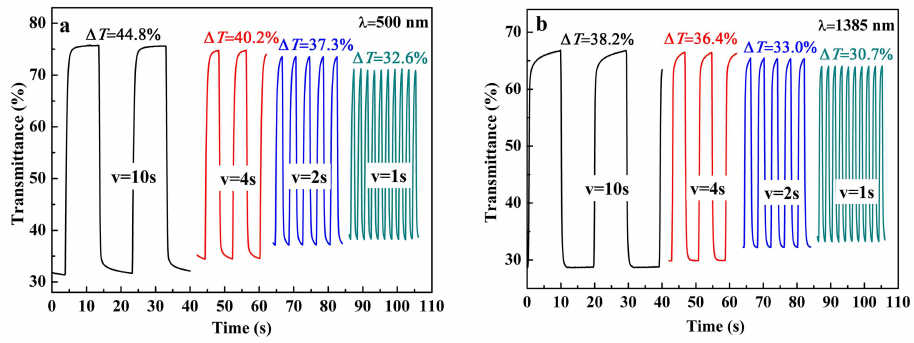
Figure 7. Electrochromic switching of P2 with intervals of 10, 4, 2 and 1 s, with the detection wavelength at 500 ( a ) and 1385 nm ( b ).